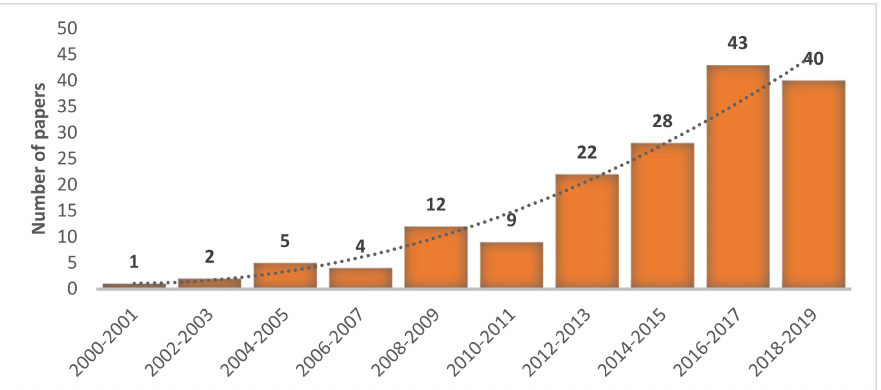
Figure 1. Temporal trends in the number of published articles linking LiDAR-based variables to the studied taxonomic groups for the period 2000–2019: Birds, mammals, reptiles and amphibians, invertebrates, bryophytes, lichens, and fungi. Note that no article published before 2000 was retrieved using search strings (see methods). The year 2020 was not included, since literature search was conducted until